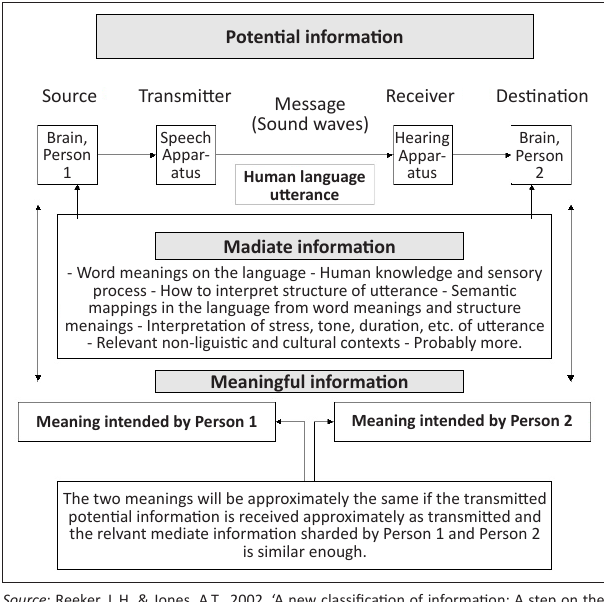
FIGURE 1 : The conveyance of knowledge